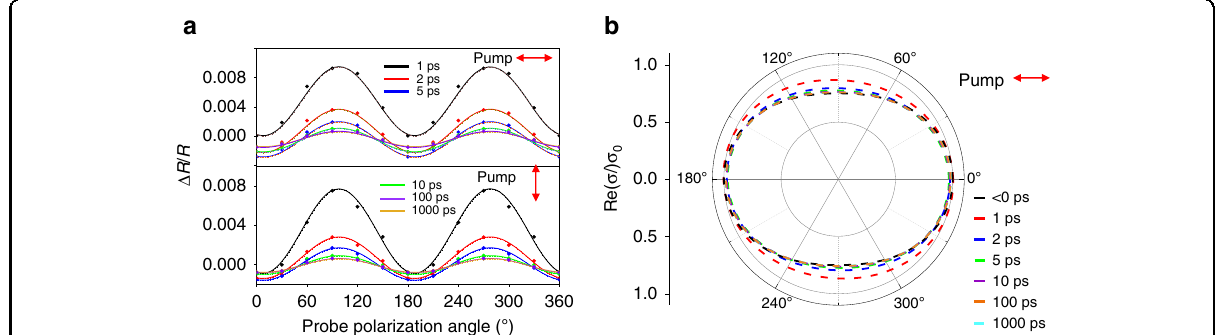
x -axis as marked in Fig. 1. φ is a fi tting angle and φ = 98° from the fi tting,